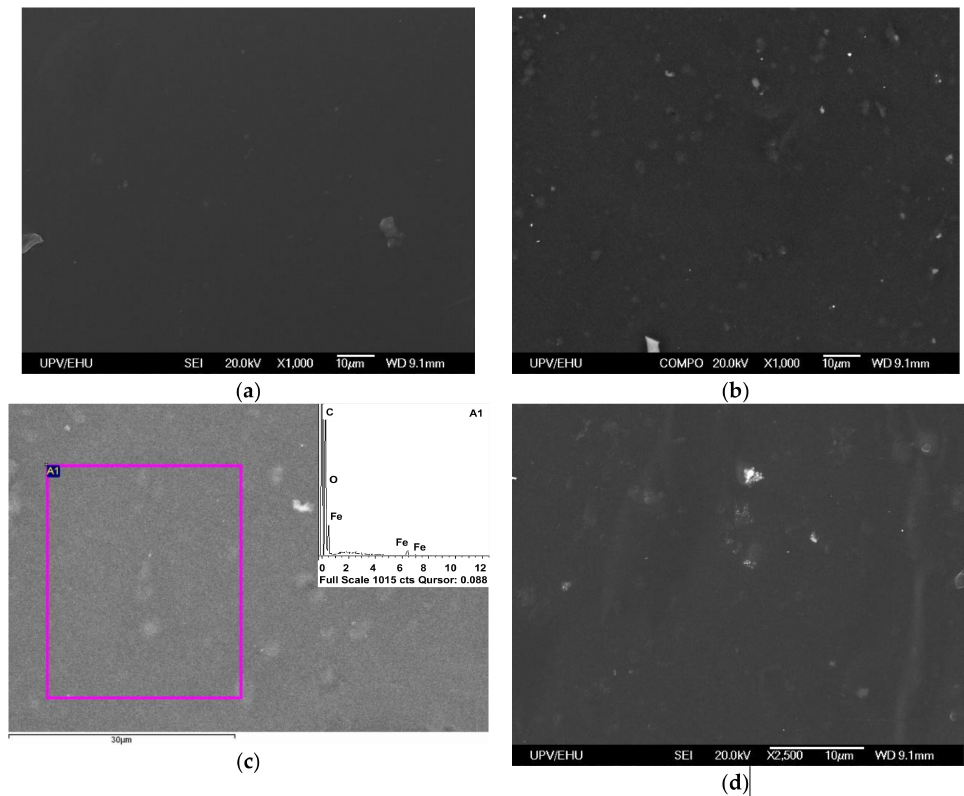
Figure 8. SEM studies of the surface of dried PAAm gel ( a ) and ferrogel with 0.34 wt.% γ -Fe 2 O 3 MNPs ( b – d ). ( c ) Area of EDX analysis, the inset of which shows the elemental